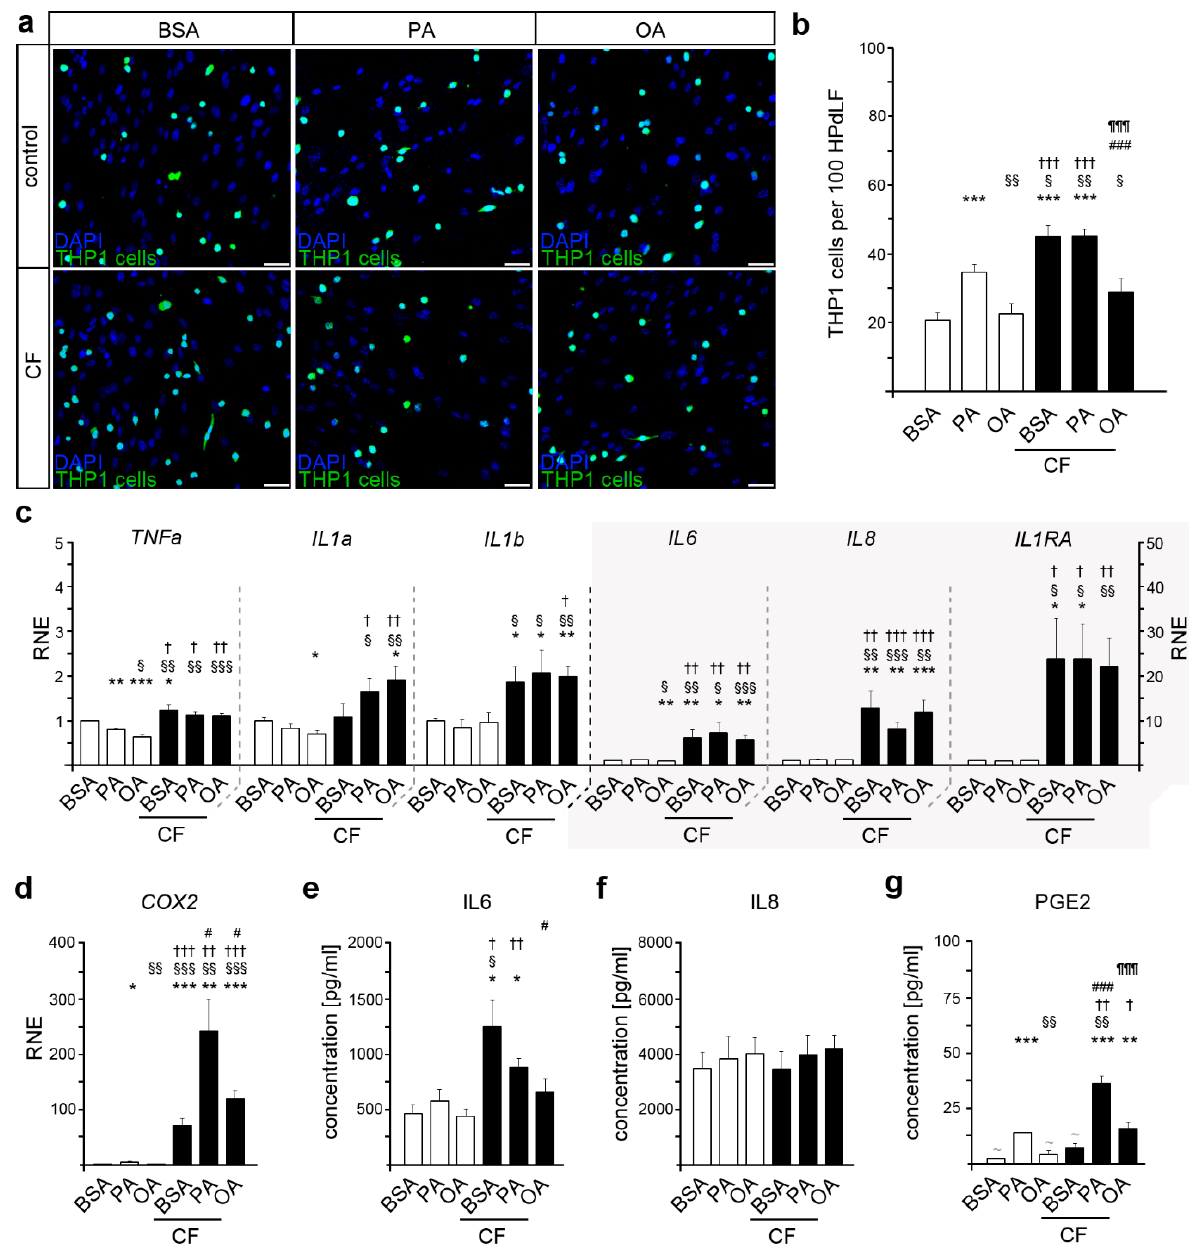
Figure 1. Palmitic and oleic acid influence the inflammatory response of human periodontal ligament fibroblasts (HPdLF) to compressive force of six hours (CF). ( a , b ) Analysis of the number of adherent THP1 monocytic cells (green) on HPdLF (blue), stimulated either with palmitic or oleic acid in comparison to BSA control ( a ). THP1 cells were stained with CellTracker™ and the nuclei of all cells were stained with DAPI. The relative number of THP1 cells is displayed per 100 HPdLF ( b ). ( c , d ) Quantitative expression analysis of genes coding for inflammatory markers TNF α , IL1 α , IL1 β , IL6 , IL8 , IL1RA ( c ), and COX2 ( d ) in fatty acid-cultured HPdLF stimulated with 6 h of compressive force in comparison to BSA controls. Results are normalized to unstimulated BSA controls. ( e – g ) Analysis of secreted cytokines IL6 ( e ), IL8 ( f ), and PGE2 ( g ) in HPdLF cultures stimulated with palmitic or oleic acid and six hours of compressive force compared to BSA controls. * p < 0.05; ** p < 0.01; *** p < 0.001 in relation to BSA, § p < 0.05; §§ p < 0.01; §§§ p < 0.001 in relation to PA, † p < 0.05; †† p < 0.01; ††† p < 0.001 in relation to OA, # p < 0.05; ### p < 0.001 in relation to BSA+CF, ¶¶¶ p < 0.001 in relation to PA + CF; one-way ANOVA and post hoc test (Tukey). Scale bars: 50 µ m in ( a ). BSA, bovine serum albumin; CF, compressive force; OA, oleic acid; PA, palmitic acid; RNE, relative normalized expression; ~ , below detection